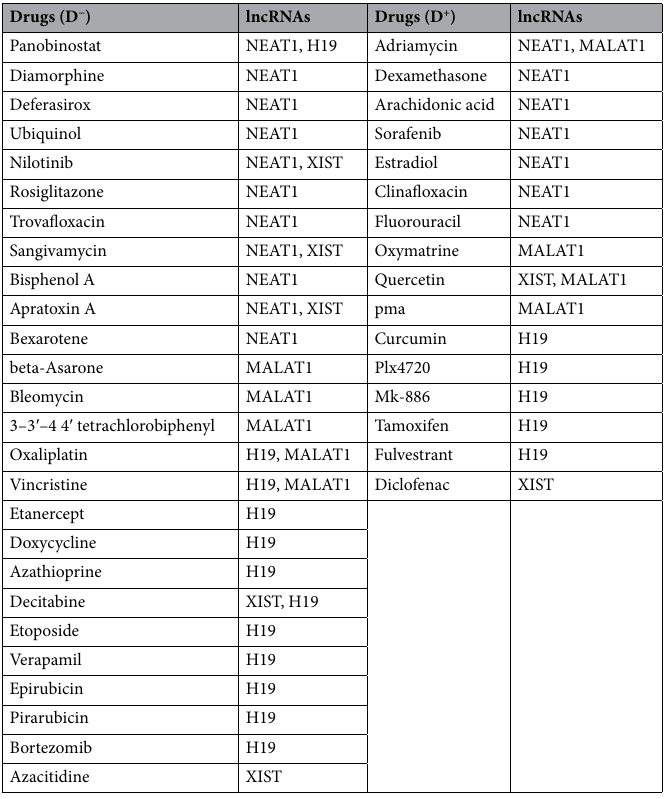
Table 5. Drugs and the corresponding lncRNAs. The drugs in the first column (D-) and the third column (D+) have a negative and positive effect on the common significant lncRNAs in DM and AD respectively. Furthermore, the interaction of lncRNAs with drugs is reported in columns 2 and 4, respectively.